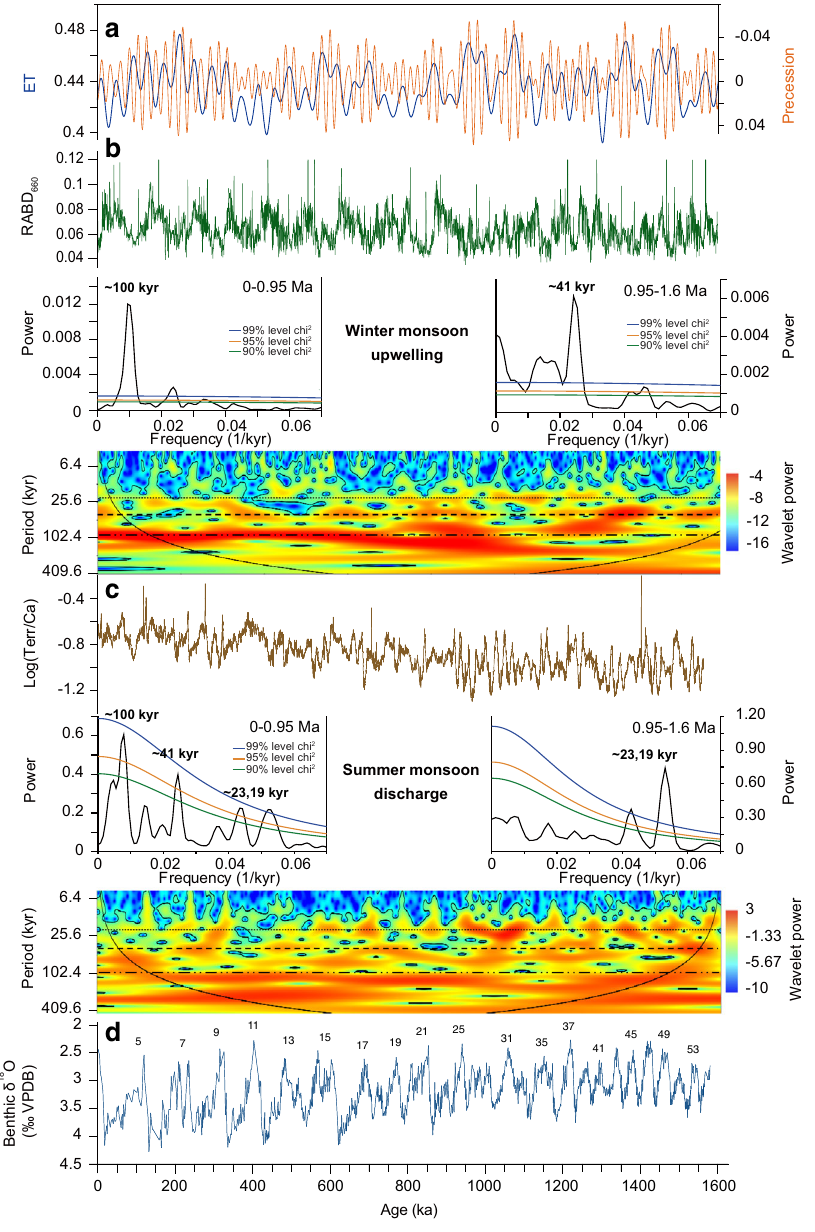
Fig. 3 | Spectral characteristics of Australian Summer and Winter Monsoon proxy records across the Middle Pleistocene Transition. a Eccentricity and obliquity (ET), precession parameter from ref. 119. b U1483 re fl ectance spectro- scopy RABD 660 data. c U1483 XRF-scanner-derived Log(Terr/Ca). d U1483 benthic